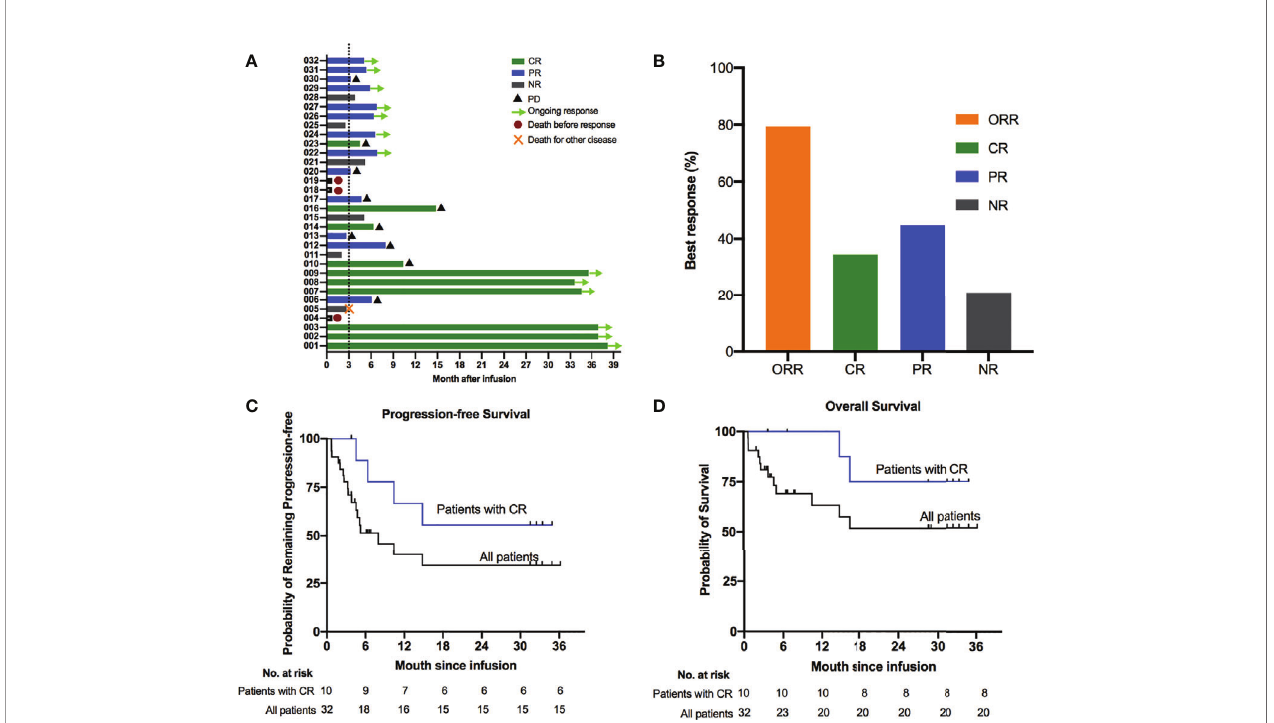
FIGURE 1 | Clinical outcomes of treatment with bispeci fi c CD19/22 CAR T cells. Survival using the Kaplan – Meier method among patients treated with bispeci fi c CD19/22 CAR T cells. (A, B) The best overall response rate was 79.3%, and 34.5% of patients achieved a complete response (CR). The median progression-free survival (PFS) was 6.8 months; (C) PFS rates were 51.4% at 6 months and 40.0% at 12 months. (D) The median overall survival was not reached, with overall survival rates were 69.1% at 6 months and 63.3% at 12 months. (C, D) Patients who achieved CR after the CAR T cells infusion experienced prolonged survival compared with those without CR, with the estimated PFS and OS rate at 12 months were 66.7% and 100%,